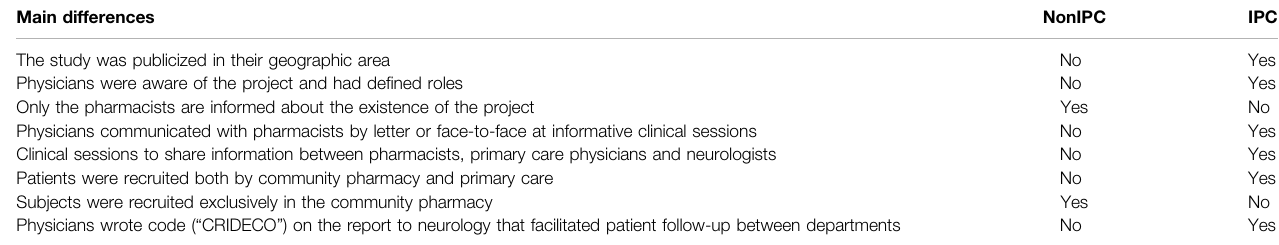
TABLE 2 | Differences in the protocol between NonIPC group and IPC